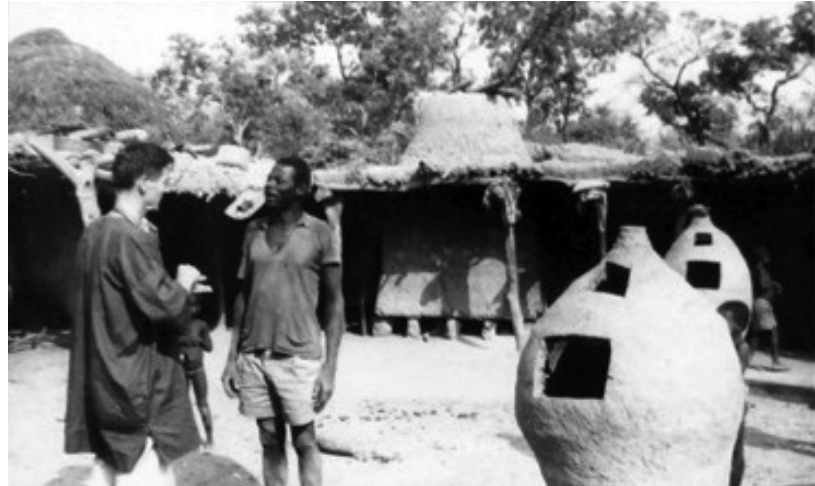
Figure 6. John Lloyd at the chief’s compound in Maluwe, Northwest Ghana, 1964. Source: Courtesy of John [Michael] and Catherine